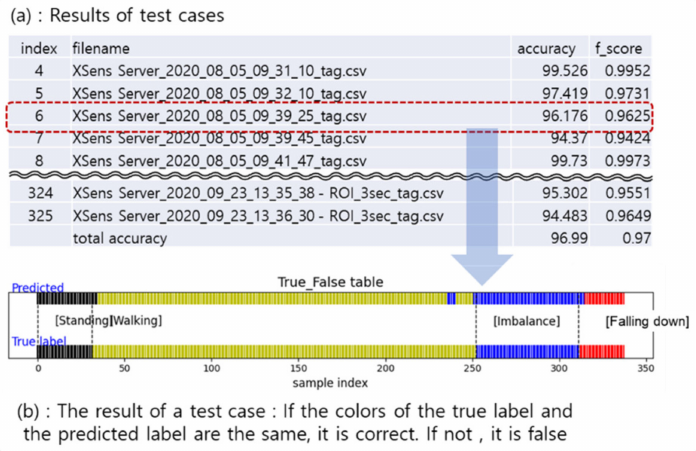
Figure 7. Recognition rates of learning models according to cases.